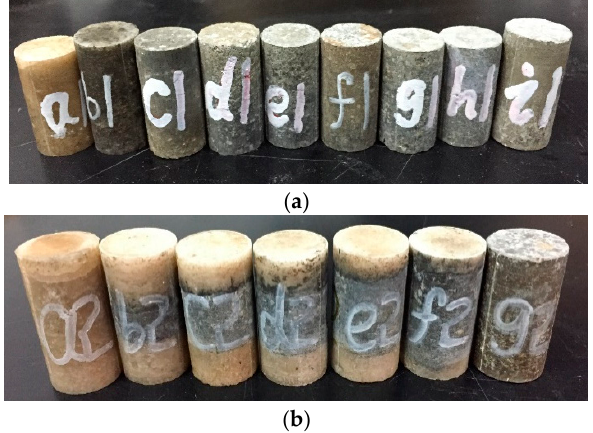
Figure 4. Synthetic specimens. ( a ) Mixed rock salt with mudstone specimens; ( b ) specimens of layered rock salt with mudstone.